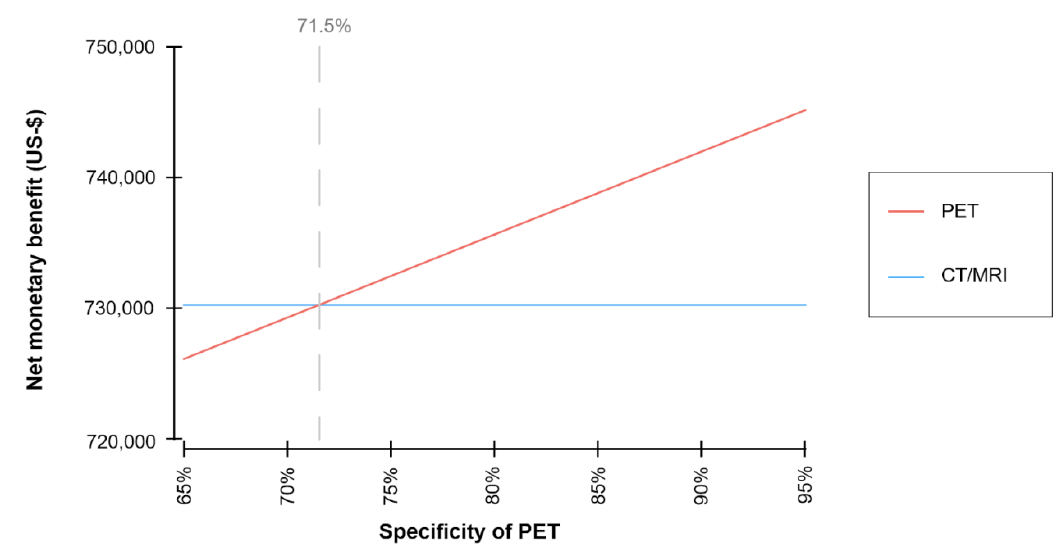
Figure 3. Net monetary benefits of 18 F-FDG-PET/CT and CT/MRI depending on varying specificity of 18 F-FDG-PET/CT. For a minimum specificity of 18 F-FDG-PET/CT of 71.5%, the PET/CT-strategy resulted in superior net monetary benefits (U.S.-$).